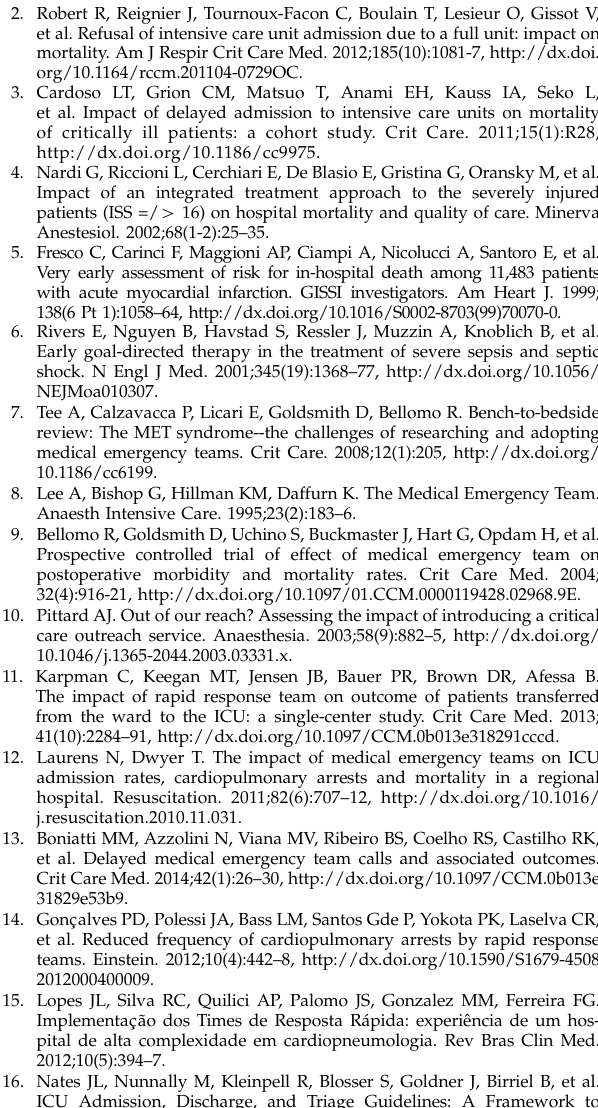
Figure 1 - Median daily costs and 95% confidence intervals for the survivors and non-survivors in the first week of the study